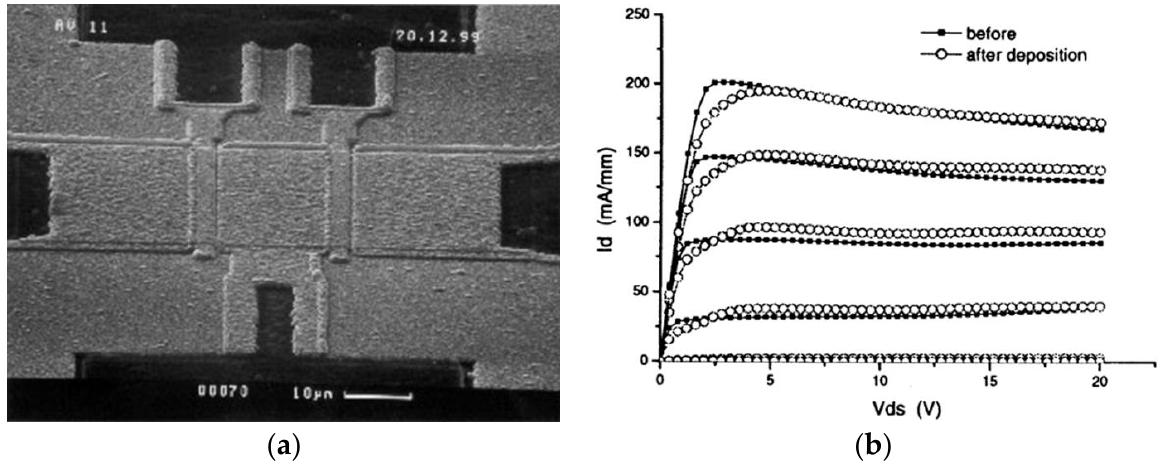
Figure 15. ( a ) Reflection electron microscope image (REM) and ( b ) Transfer characteristics of a two-